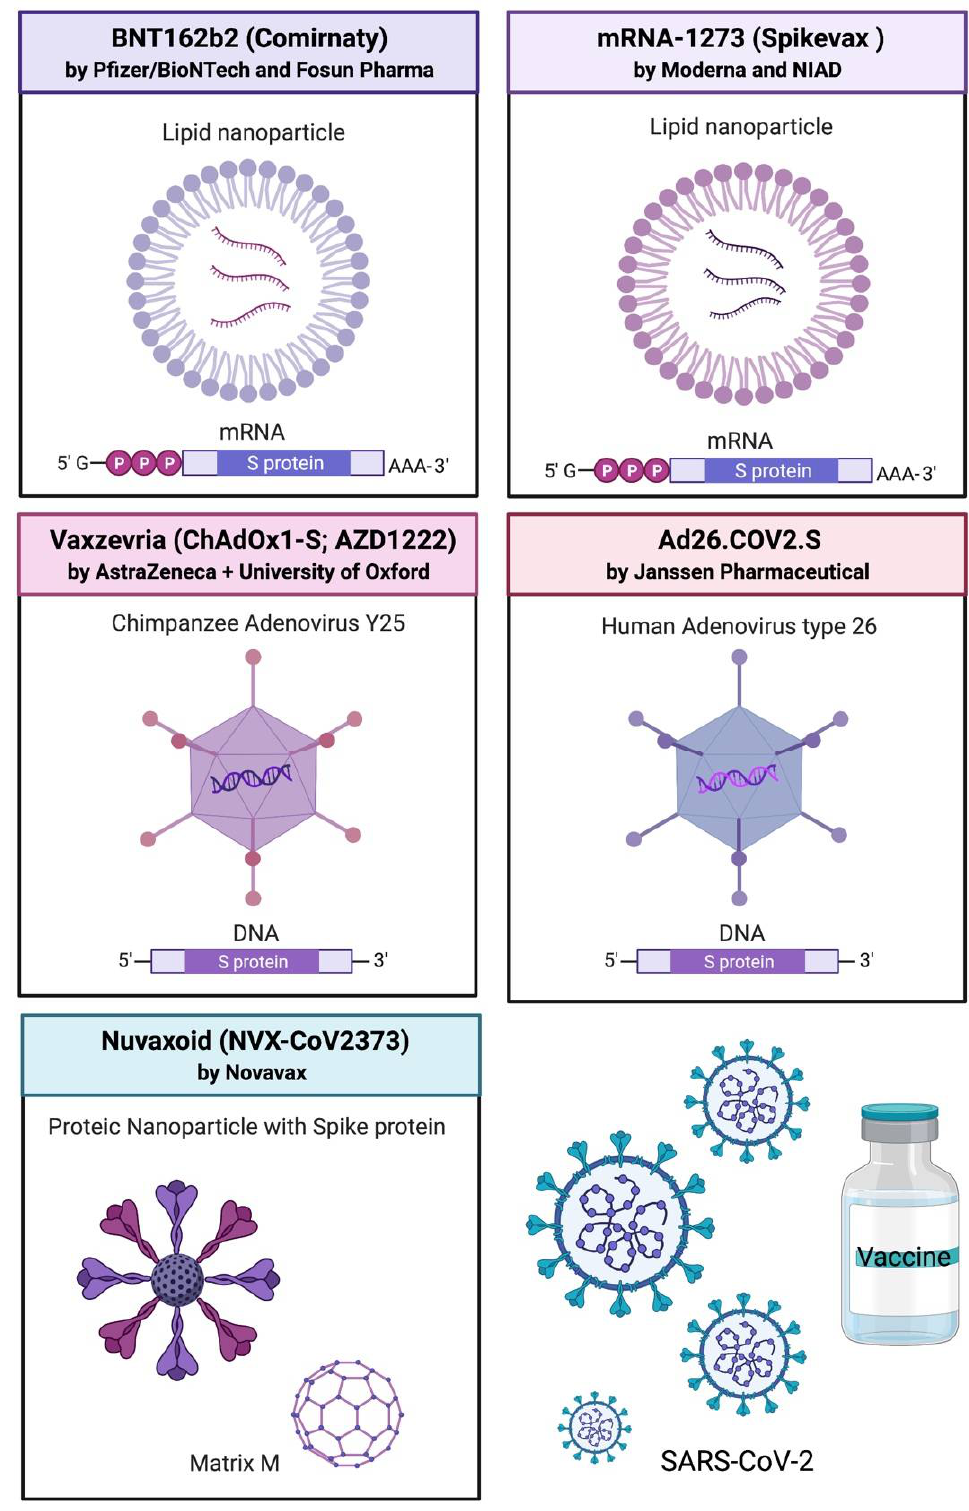
Figure 4. Currently available and approved nanovaccines against SARS-CoV-2. 6.1. BNT162b2 (3 LNP-mRNAs, Comirnaty) by Pfizer/BioNTech and Fosun Pharma BNT162b2 is an mRNA-based vaccine encapsulated in lipid nanoparticles encoding for the membrane-anchored SARS-CoV-2 full-length spike (S) protein, modified with two